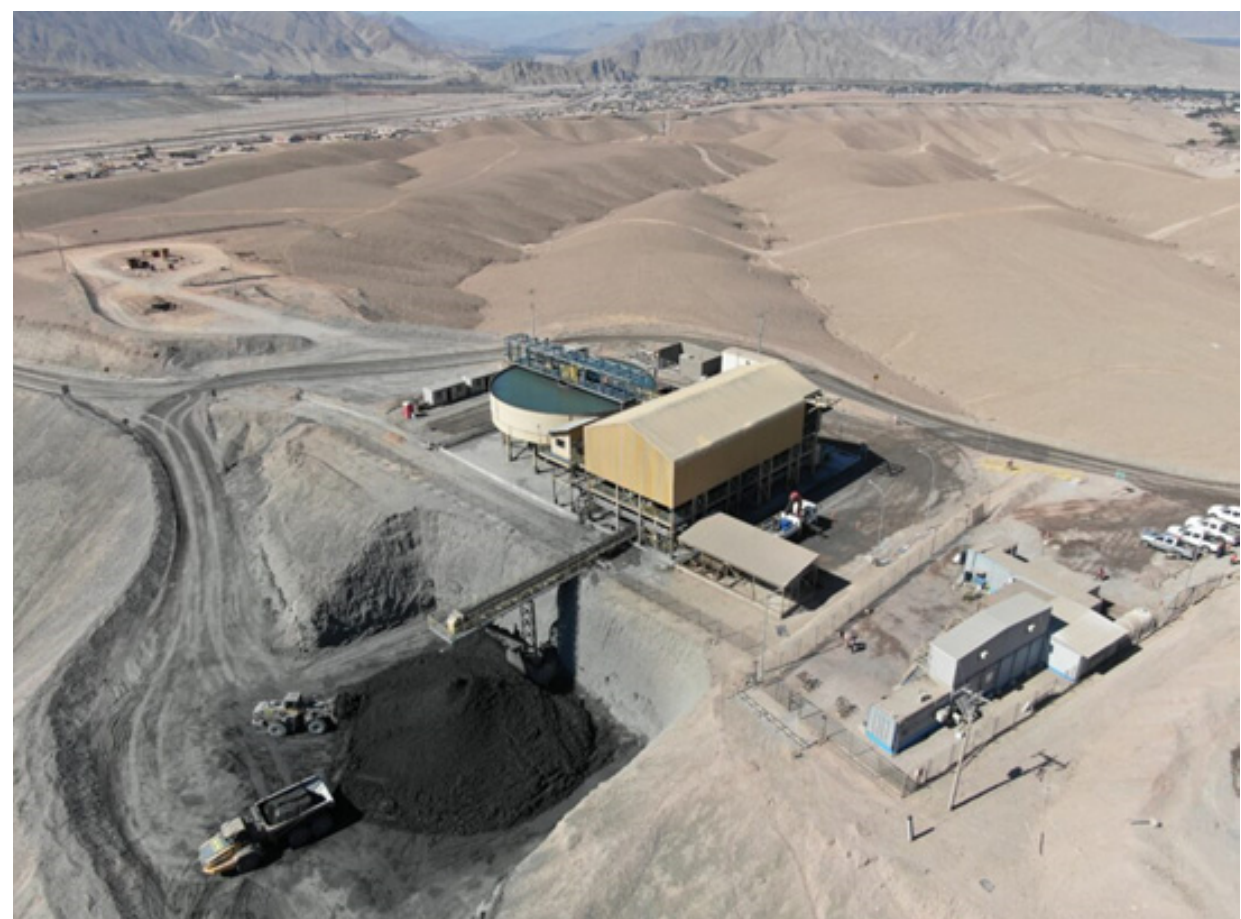
Figure 28. El Gato Creek Filtered Tailings Plant [27,47,61].